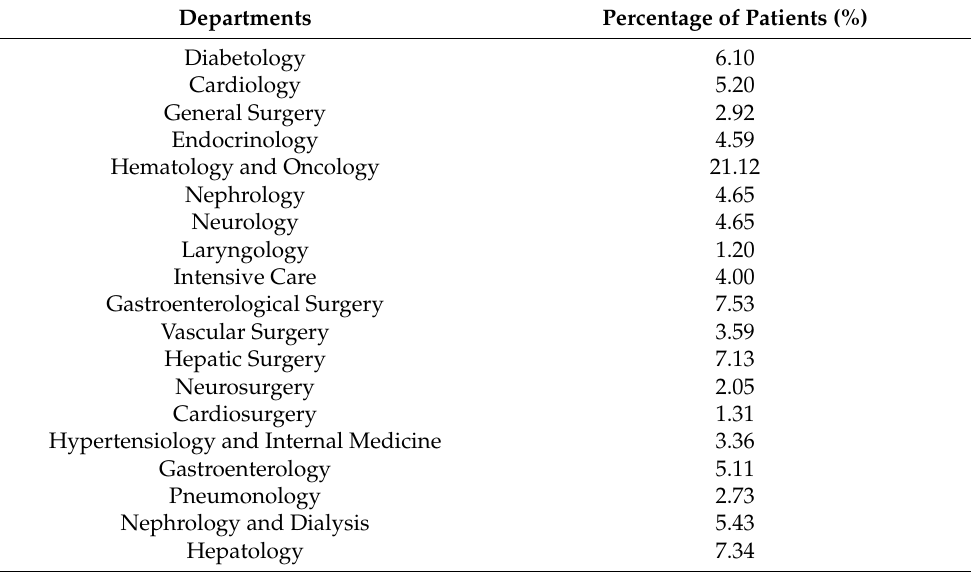
Table 1. Percentage of patients from individual hospital